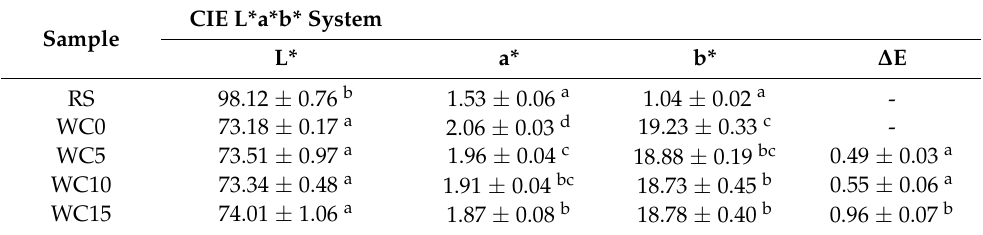
Table 4. Color (CIE L*a*b* system) on the surface of RS and enriched white chocolate